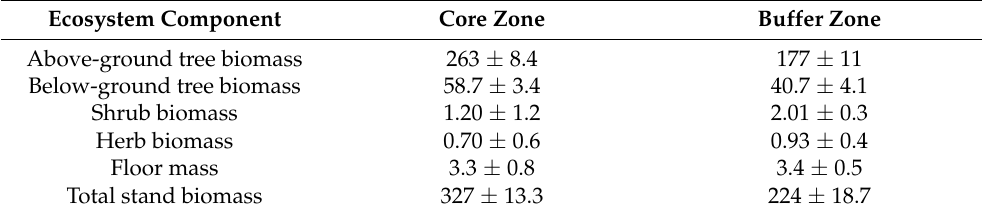
Table 3. Total biomass (Mg ha − 1 ) (mean ± standard error) in core and buffer zones of Minkong Community Reserve Forest, Nagaland, India).